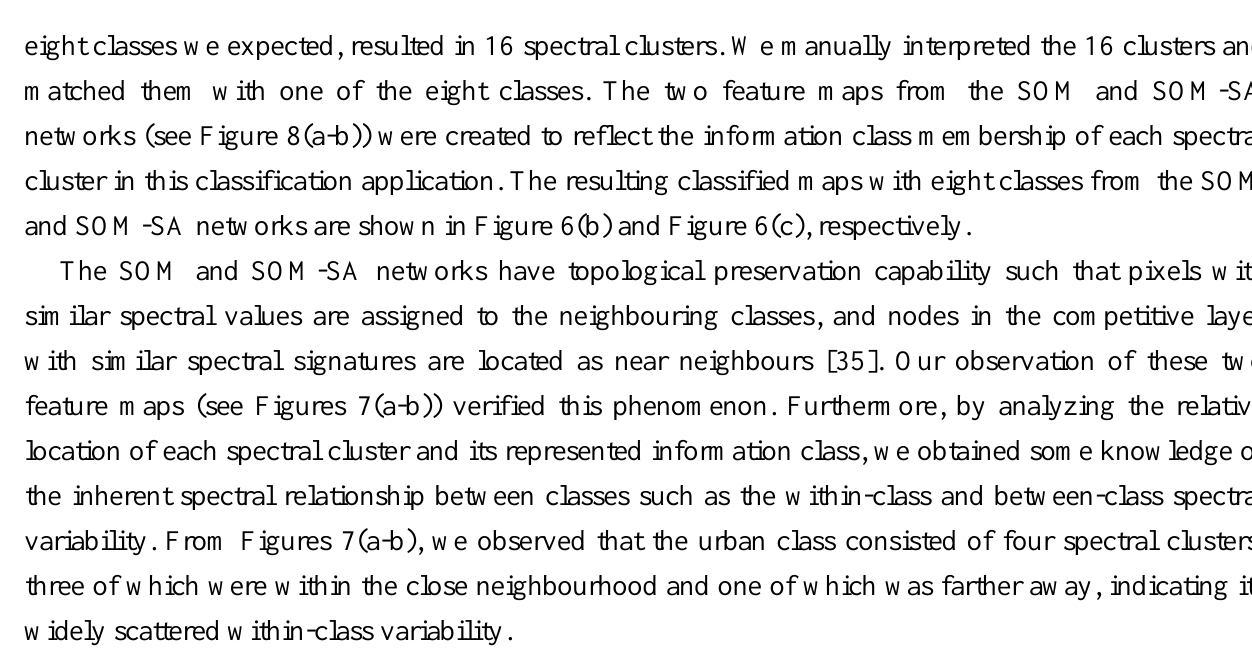
Figure 7. Topological maps from the SOM and SOM-SA networks where U: Urban, F: Forest, C: Crop field, G: Grassland, B: Bare soil, T: Transitional area, WW: Woody wetland, W: